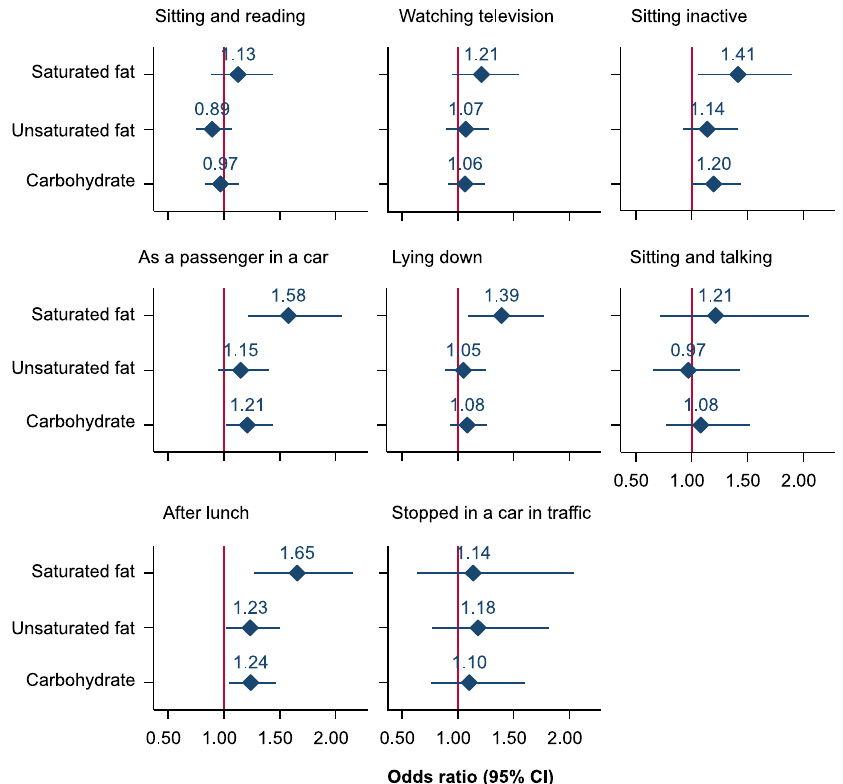
Figure 3. Odds ratios (95% confidence intervals) for excessive daytime sleepiness associated with a 5% decrease of energy per day from protein and a simultaneous 5% increase of energy per day from saturated fat, unsaturated fat, and carbohydrate in the North West Adelaide Health Study. (Nutrient density model. The model was adjusted for total energy intake from fat, carbohydrate, protein, sex, age (continuous), marital status, education, work status, Socio-Economic Indexes for Areas, waist-to-hip ratio (continues), alcohol intake, exercise level, sleep duration, pulse pressure (continuous), sleep apnea, diabetes status, and depression.).